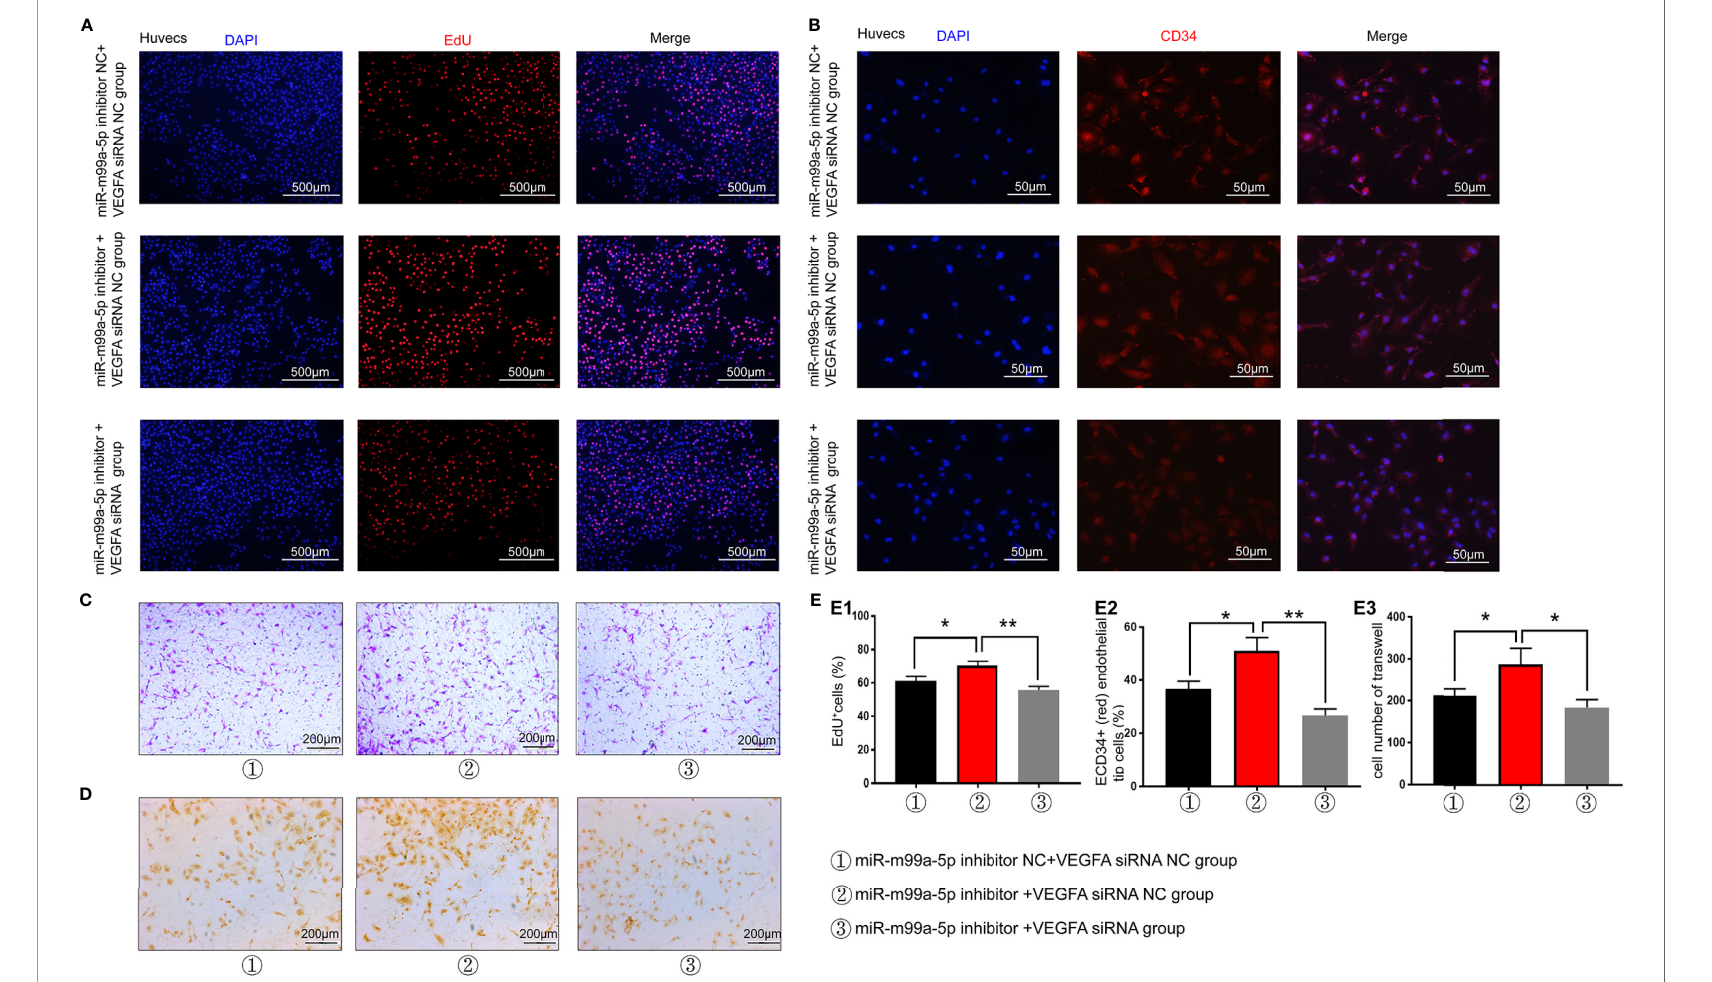
FIGURE 6 | miR-199a-5p rescue experiment results. (A) EdU experimental results suggest that the effect of the miR-199a-5p inhibitor on cell proliferation can be reversed by VEGFA-siRNA. (B) The ratio of immuno fl uorescence analysis of CD34+ (red) endothelial tip cells was decreased after HUVECs were transfected with miR-199a-5p-inhibitor and VEGFA-siRNA. Nuclei were stained with DAPI (blue). (C) Transwell experiment results of each group of cells. (D) CD31 immunohistochemistry experiment results of each group of cells. (E) Experimental quantitative data. E1, Quantitative data of EdU experiment. E2, Quantitative CD34 immuno fl uorescence experiment data. E3, Quantitative data of cell Transwell experiments. ** represents a statistically signi fi cant difference compared with the other groups (P < 0.01). *P <